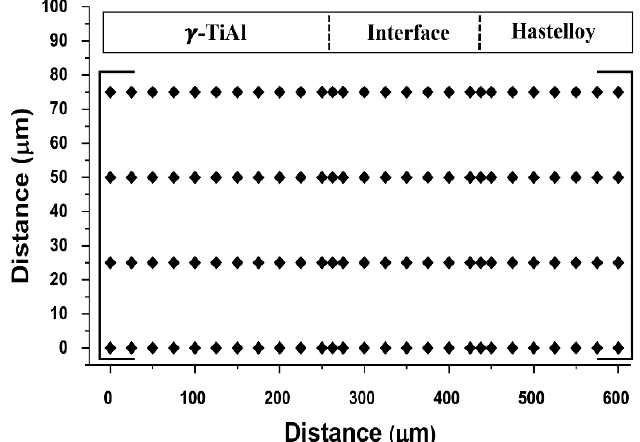
Figure 2. Scheme of the matrix for the Vickers microhardness tests showing the indentation position ( ♦ ) across the joints .